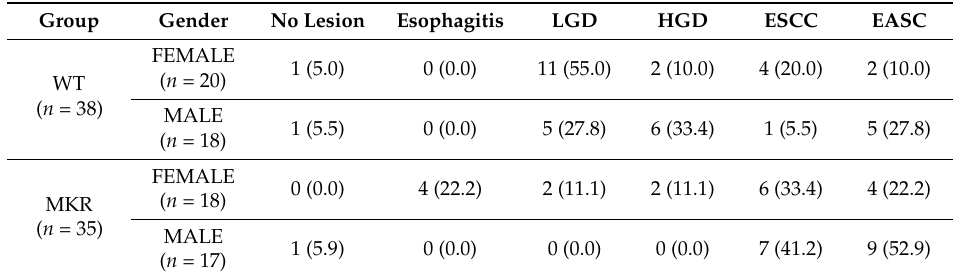
Table 2. Incidence of esophageal pathological changes in wild-type (WT) females and males and hyperinsulinemic (MKR) females and males mice with duodenal reflux. Data show the numbers of mice, with percentages in parentheses. Animals were divided by gender; dysplastic lesions were divided based on the degree of histologic abnormality in LGD (Low-Grade Dysplasia) and HGD (High-Grade Dysplasia); neoplastic lesions were divided by histotype in ESCC (Esophageal